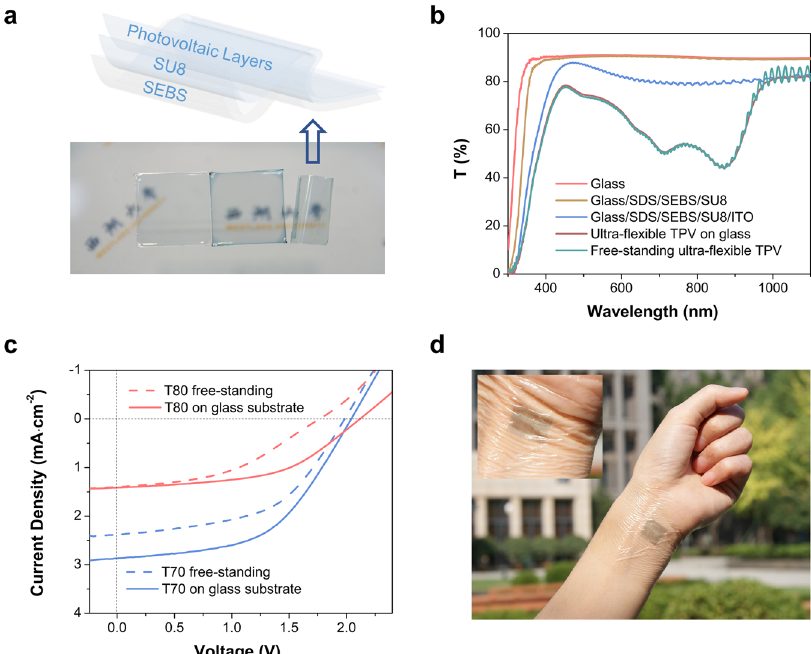
Fig. 6 Properties of the ultra- fl exible TPV devices. a Architecture of the ultra- fl exible TPV device. The bottom photograph shows the ultra- fl exible substrate (left), ultra- fl exible TPV devices on the glass substrate (middle), and the free-standing ultra- fl exible TPV device (right), respectively. b Transmission properties for the substrate, fi lm and device. c J – V characteristics for ultra- fl exible TPVs with AVT of ~70% (T70) and AVT of ~80% (T80) before and after peeled off from the glass substrate. d The ultra- fl exible TPV device attached conformably to a human wrist (the inset shows the details of the ultra- fl exible TPV device when bent the